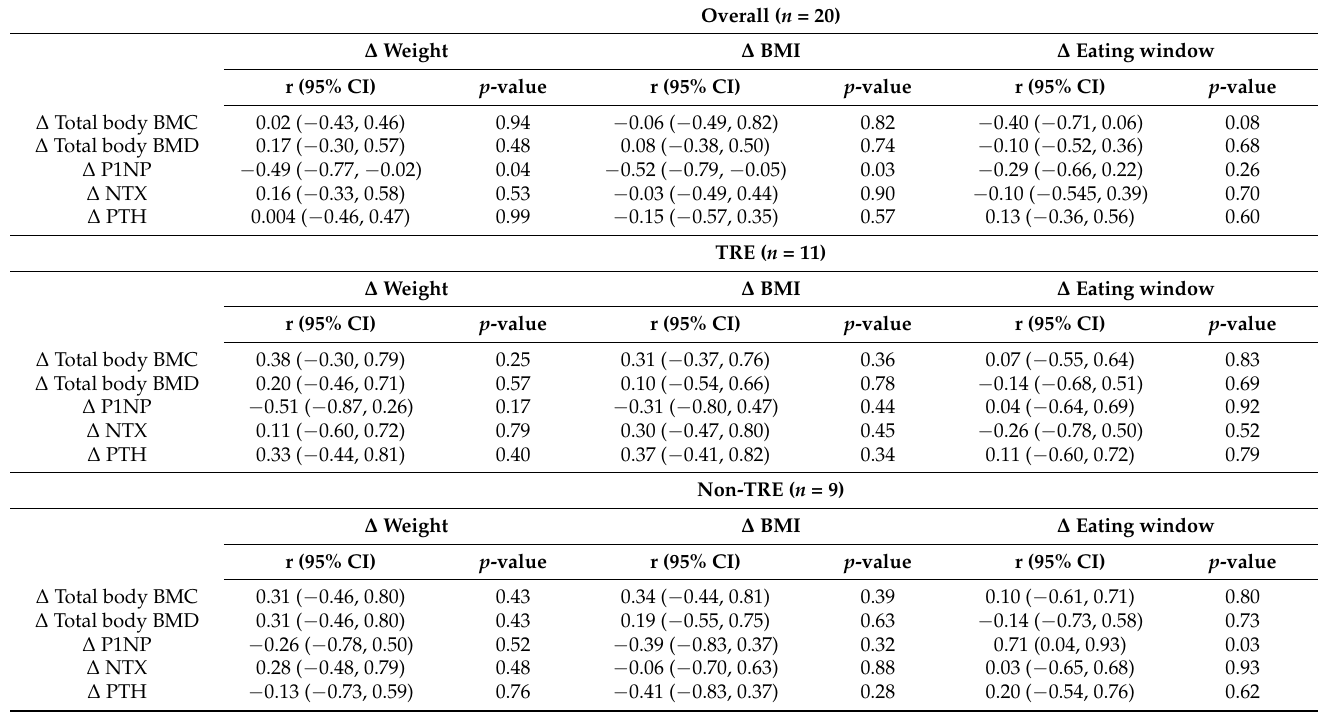
“ ∆ ” or change values represent the mean of post-intervention values minus pre-intervention values. BMI, body mass index; BMC, bone mineral content; BMD, bone mineral density; P1NP, procollagen 1 N-terminal propeptide; NTX, cross-linked N-telopeptide of type I collagen; PTH, parathyroid